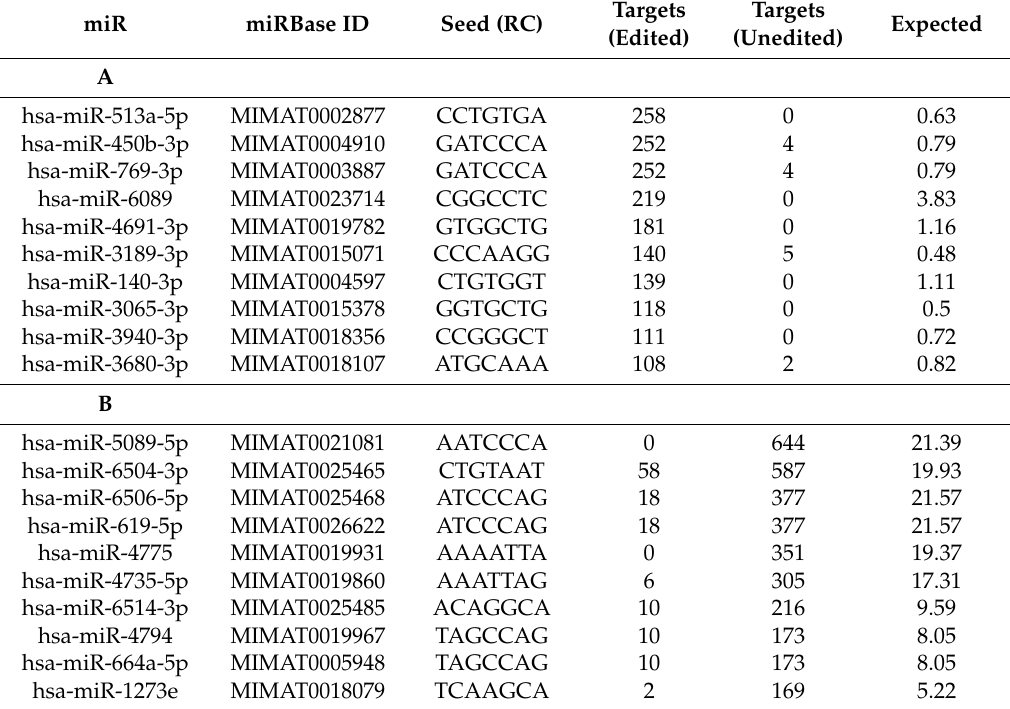
Table 1. List of top 10 miRs where ADAR editing of mRNAs alters complementarity to miR seed regions and either ( A ) creates novel target sites for regulation or ( B ) destroys predicted target sites. In addition to altered edit complementarity, microRNAs included were also required to be present